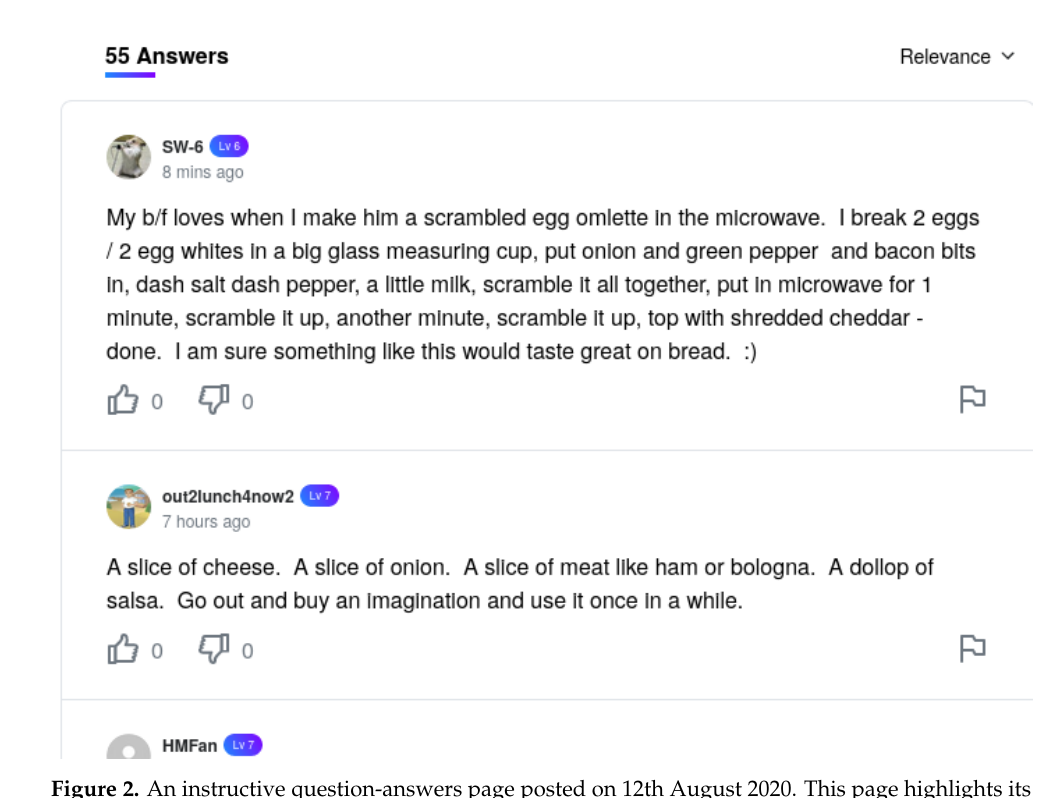
Figure 2. An instructive question-answers page posted on 12th August 2020. This page highlights its title, the body and two of its